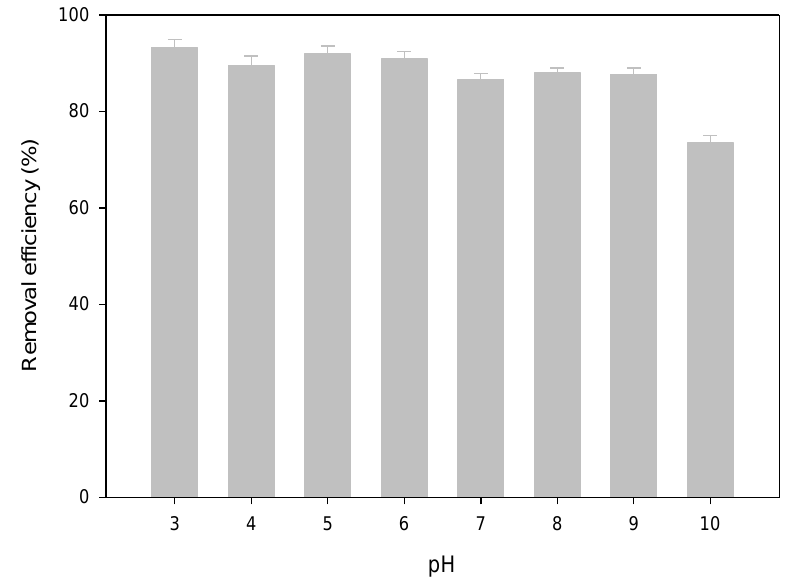
Figure 1. Bisphenol A (BPA) removal efficiency of activated carbon AC-40 according to the pH of the medium.